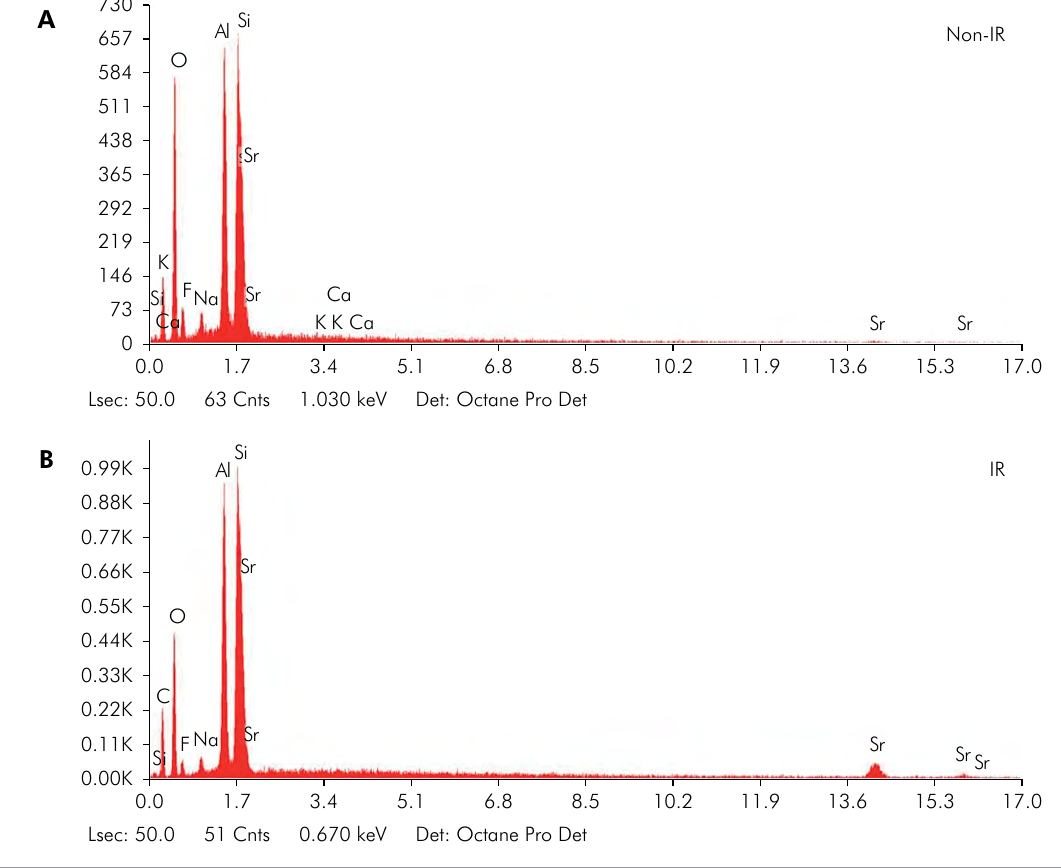
Figure 4. A: EDS spectra acquired from Beautifil II in the Non-IR (non-irradiated) subgroup. All materials showed predominance of oxygen, aluminum, and silicon in both the Non-IR and IR subgroups; B: EDS spectra acquired from Beautifil II in the IR (irradiated) subgroup. All materials showed predominance of oxygen, aluminum and silicon in both the Non-IR and IR subgroups.